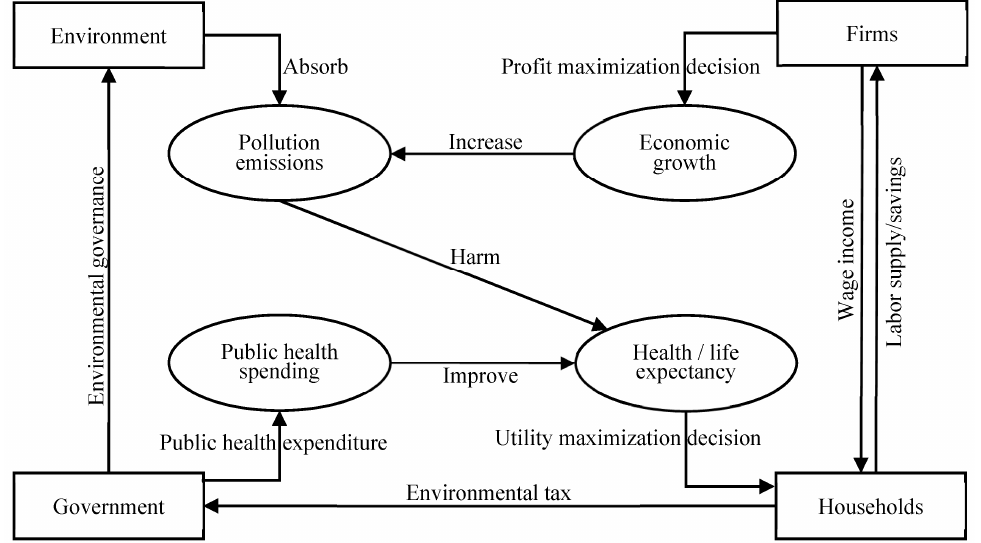
Figure 4. The logical framework of this article.